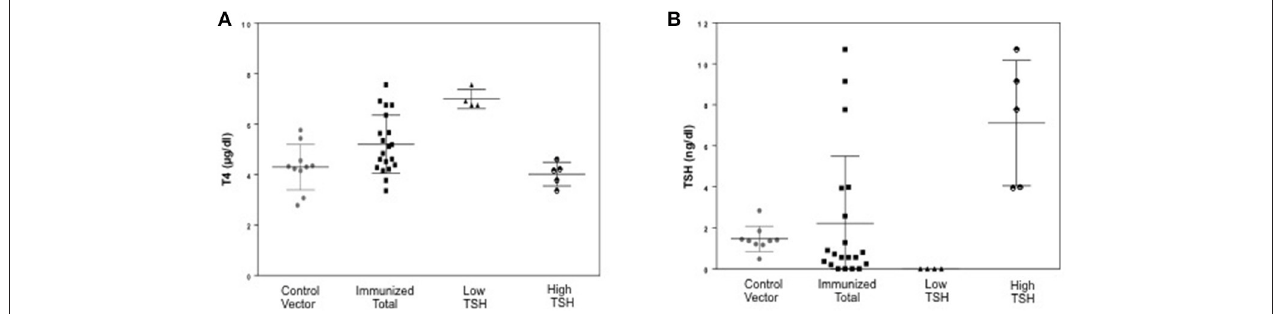
FIGURE 3 | Thyroid function tests of immunized animals. (A) Serum TSH levels: T4 and TSH were detected using multiplex bead assay (Millipore) as described in materials and method. The average TSH level was 1.46 ± 1.26 ng/dL in the control animals vs. 2.22 ± 6.56 ng/dL in the immunized group. When the immunized group was subdivided into low and high TSH groups, 25% of mice had high TSH levels. (B) Serum T4 levels: Average T4 level was 4.29 ± 1.72 µ g/dL in the control animals vs. 5.20 ± 2.32 µ g/dL in the immunized group. 20% of the immunized animals had elevated T4 with corresponding suppressed TSH. There was significant difference ( p < 0.0001) between the high TSH and the control group only.